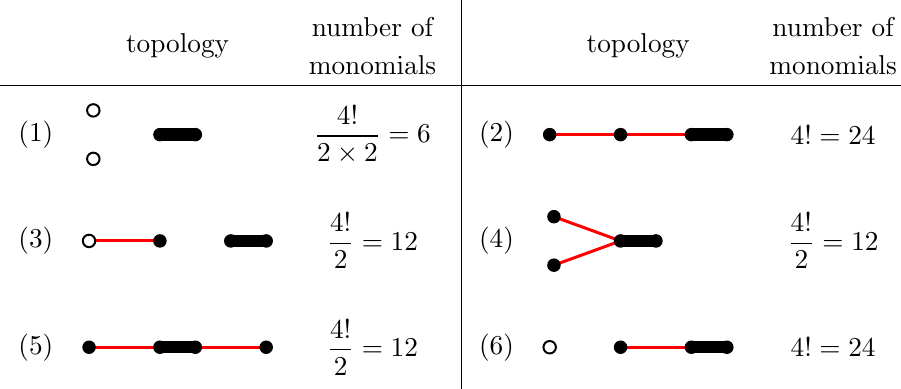
Table 1 . The topology and the number of monomials contained at six